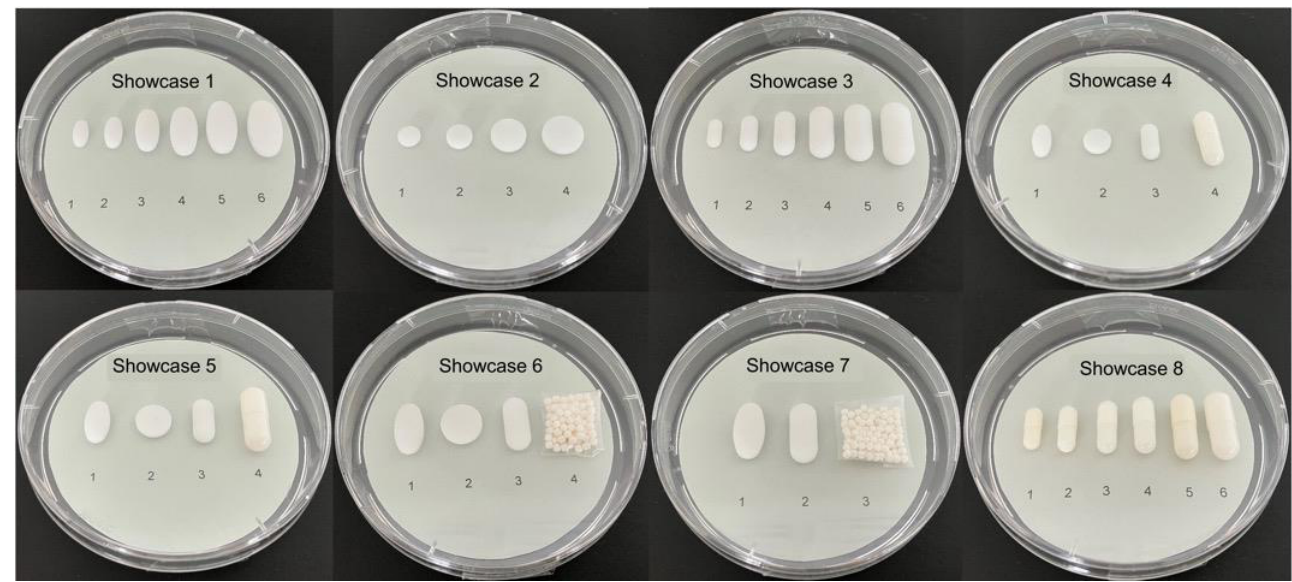
Figure 1. Eight different showcases were shown to the participants consecutively. Participants estimated the swallowability of the different dosage forms.